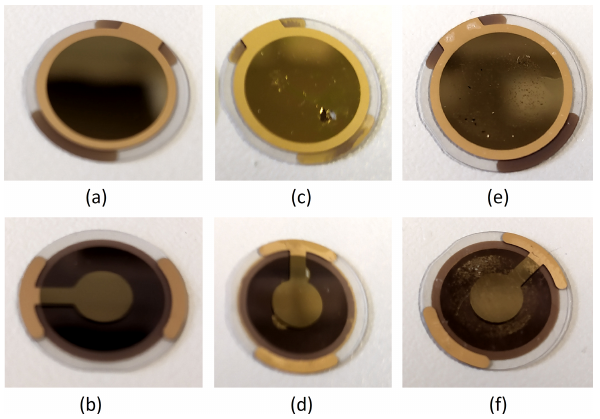
Figure 11. The surface of a quartz disk: (a, b) front and back side of a new disk, (c, d) front and back side without a PMMA layer, and (e, f) front and back side with a PMMA layer after measurement with